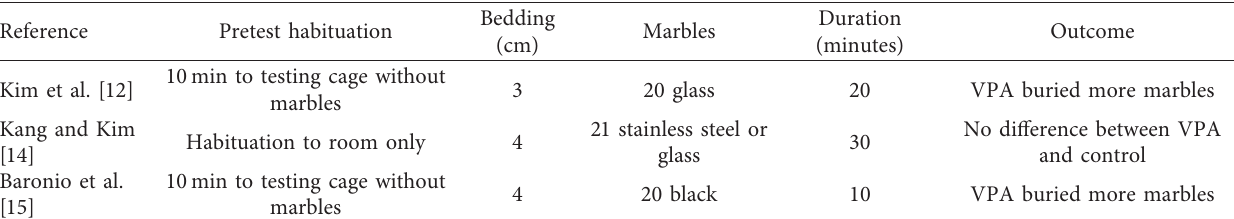
Table 5: Marble burying